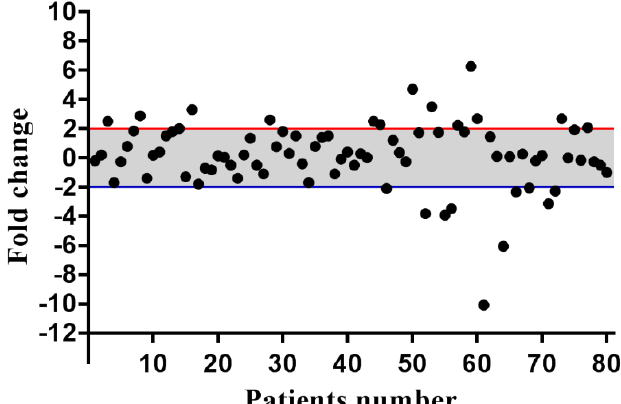
Fig. 1. Descriptive analysis of relative gene expression of KINDLIN1 in GC patients. The thresholds for the over and under- expressed cases are shown by the red and blue lines, respectively. The grey area indicates the cases with normal level of